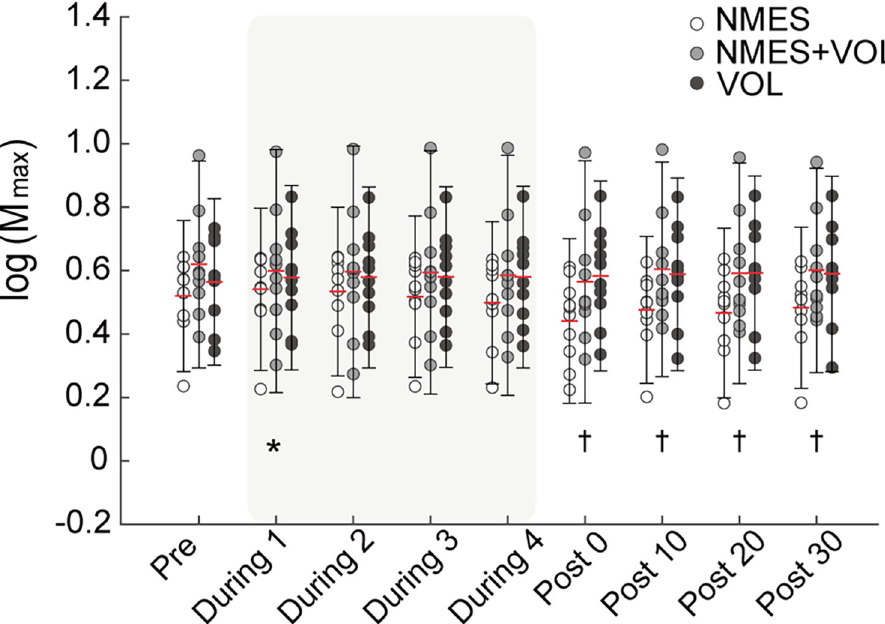
Fig 4. Changes in the M max . Circles represent each individual data and error bars represent 2 standard deviation. The red lines indicate mean for each time point. Legend: � p < .05 indicates significant differences between NMES and NMES+VOL. † p < .05 indicates significant differences between NMES and VOL. Abbreviations: NMES, neuromuscular electrical stimulation; VOL, voluntary contractions.